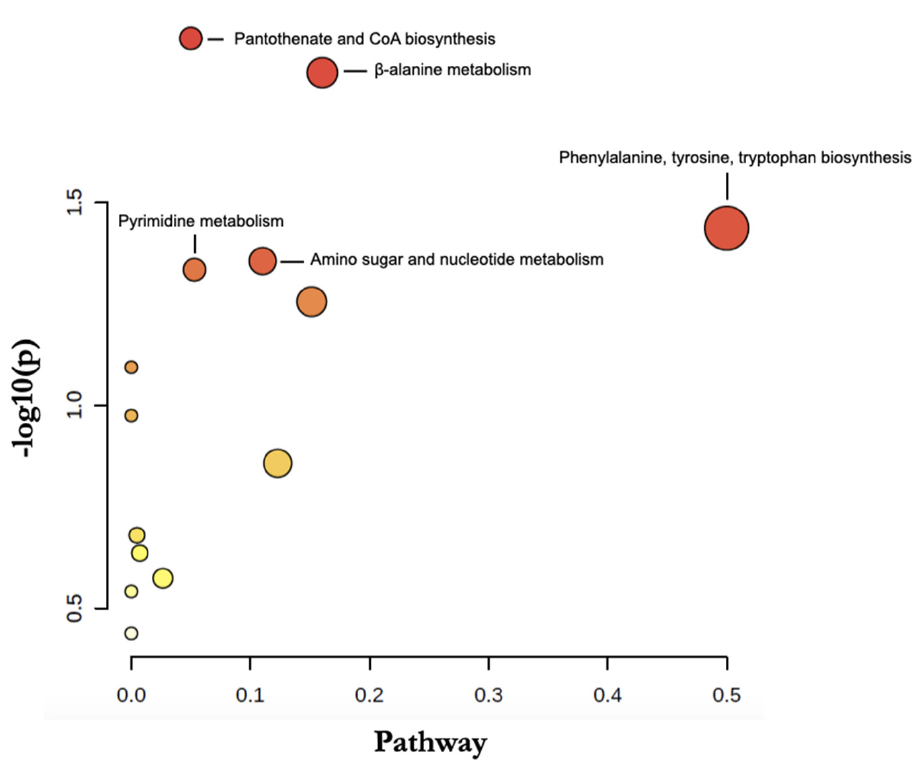
Figure 3. Metabolomic Pathway Analysis based on the 15 VIP metabolites the most discriminant in the multivariate model explaining hearing loss. The circles resume all matched pathways according to the p values from the pathway enrichment analysis and pathway impact values from the pathway topology analysis (calculated as the sum of importance measures of the matched metabolites normalized by the sum of the importance measures of all metabolites in each pathway). Each circle represents a metabolite set with its color based on its p -value (darker colors indicate more significant changes in metabolites belonging to the corresponding pathway), and its size is based on pathway impact score. The most impacted pathways are annotated.